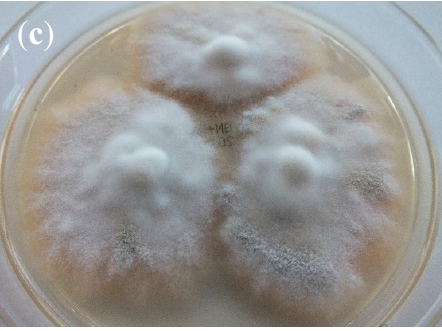
Figure 1. ( a ) Tinea corporis due to T . mentagrophytes VIII in a 34-year old female from India residing